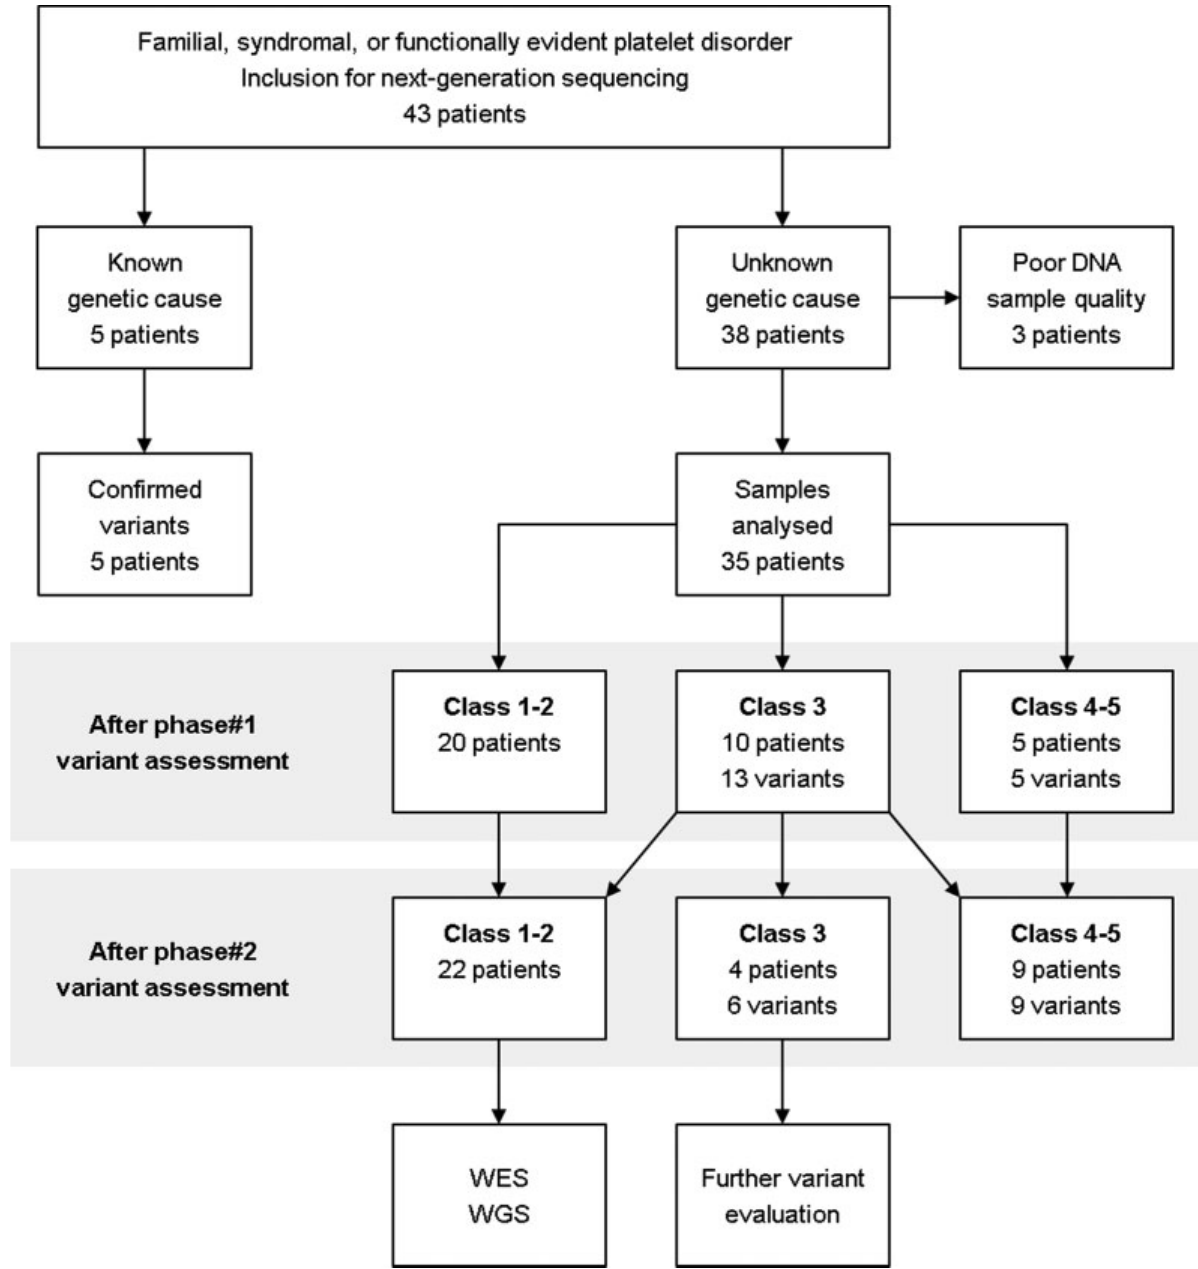
Fig. 1 Flow chart of analysis procedure and variant assessment. DNA samples of 43 individuals were processed by targeted, panel-based next- generation sequencing (absolute number of patients). In the group of patients with unknown platelet defect, variants were initially classi fi ed using in silico fi ltering programs and gene databases (phase 1 variant assessment). In a second step, class 3 variants (variants of uncertain signi fi cance) were assessed with respect to clinical phenotype, segregation analysis, literature, in vitro data, and animal models (phase 2 variant assessment). DNA, deoxyribonucleic acid; WES, whole exome sequencing; WGS, whole genome